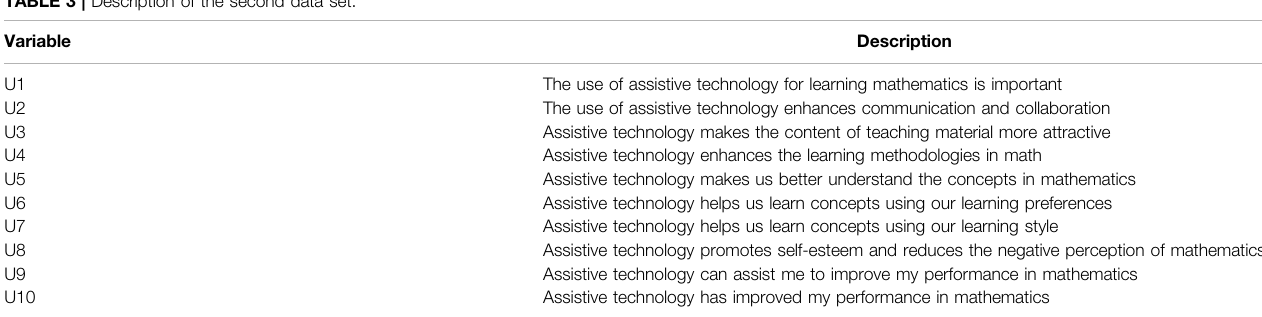
TABLE 3 | Description of the second data